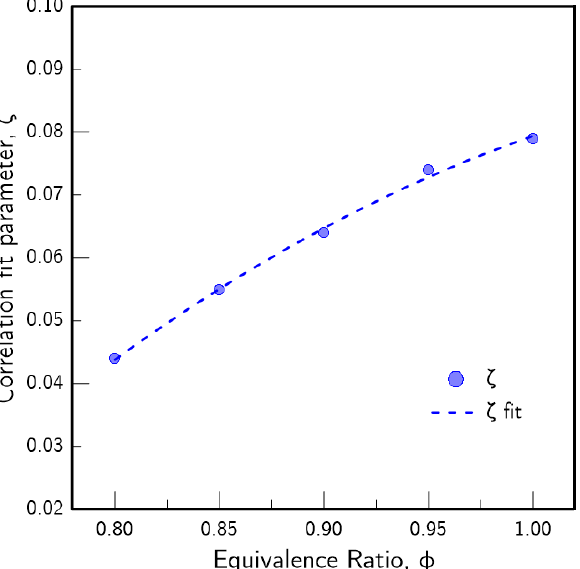
Figure 7. Variation of the fit parameter ζ with the equivalence ratio. The correspondent data fit curve is also